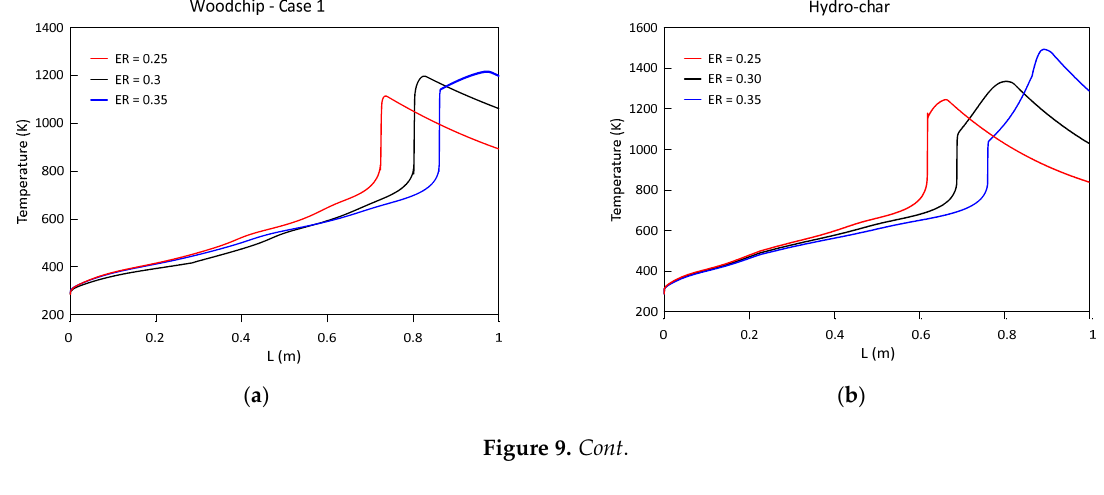
( c ) Figure 9. Temperature evolution along the reactor axis at different ER for ( a ) woodchip case 1, ( b ) hydro-char from green waste, ( c ) olive pomace.